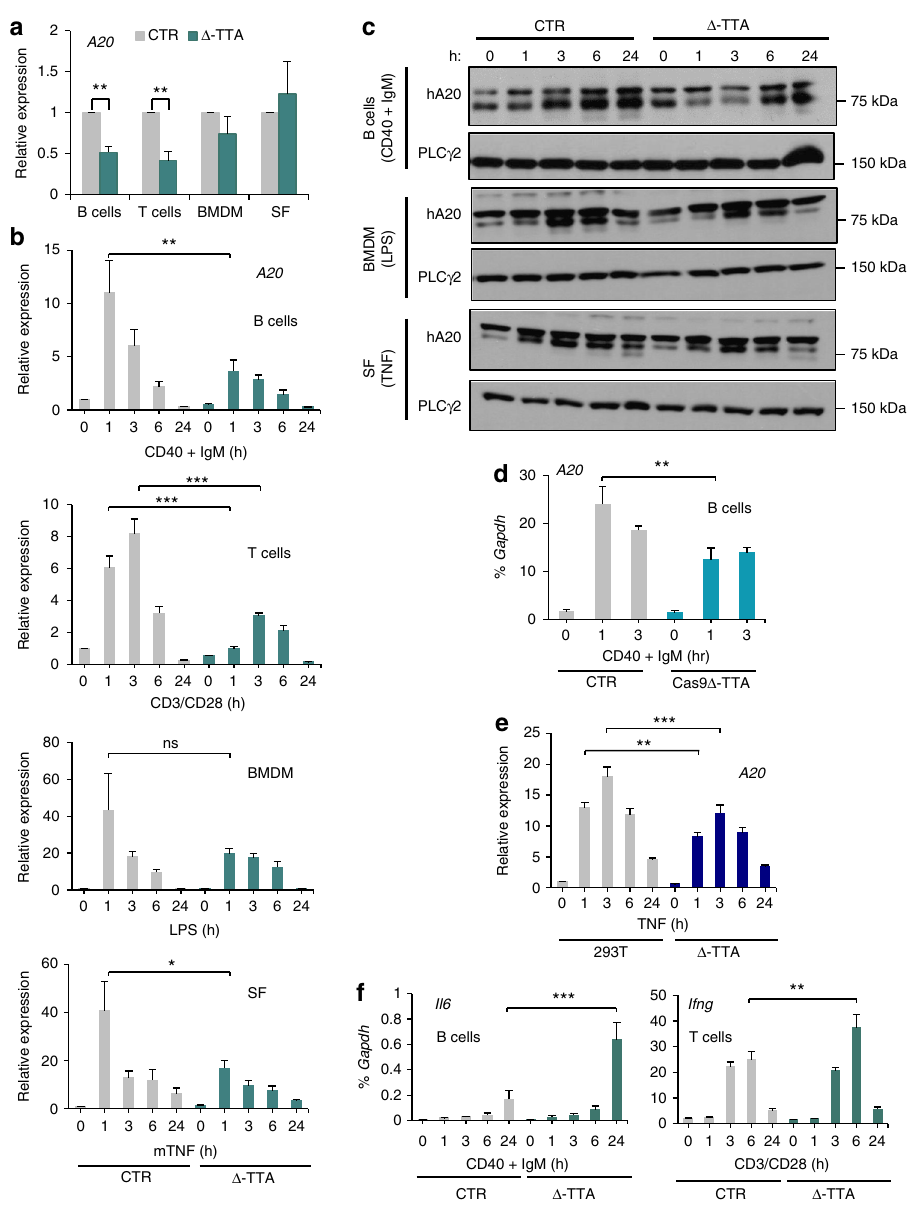
Fig. 5 Genome editing in vivo reveals cell-speci fi c and signal-responsive functions of the TT > A enhancer. a , b qPCR analysis of basal ( a ) or inducible ( b ) hA20 expression in cells from BAC transgenic mice in which TT > A enhancer was deleted using recombineering. Primary B and T cells were isolated from spleens, macrophages cultured from bone marrow (BMDM), and synovial fi broblasts (SFs) were isolated from ankle joints. B cells were stimulated with antibodies against CD40 (2 μ g ml − 1 ) and IgM (5 μ g ml − 1 ), T cells with anti-CD3/anti-CD28-coated beads (1:1 cell to bead ratio), BMDM with LPS (25 ng ml − 1 ), and SF with TNF (20 ng ml − 1 ) for the indicated times. Data are combined from three independent experiments. Error bars indicate mean ± s.e.m., statistical signi fi cance was determined using one-way ANOVA followed by Tukey ’ s multiple comparison test. * P < 0.05; ** P < 0.01; *** P < 0.001; ns, not signi fi cant. c Immunoblot analysis of hA20 protein expression. Representative of two to four experiments. Primary cells were obtained and stimulated as in b . d qPCR analysis of hA20 mRNA in B cells isolated from mice bearing a CRISPR-mediated deletion of TT > A enhancer. Error bars indicate mean ± s.e.m. of four independent experiments, statistical signi fi cance was determined using one-way ANOVA followed by Tukey ’ s multiple comparison test. ** P < 0.01. e CRISPR-mediated deletion of TT > A enhancer affects hA20 expression in 293T cells. Error bars indicate mean ± s.e.m. of fi ve independent experiments, statistical signi fi cance was determined using one-way ANOVA followed by Tukey ’ s multiple comparison test. ** P < 0.01; *** P < 0.001. f qPCR analysis of cytokine mRNA from ex vivo-stimulated B and T cells. Error bars indicate mean ± s.e.m. of three independent experiments, statistical signi fi cance was determined using one-way ANOVA followed by Tukey ’ s multiple comparison test. ** P < 0.01; *** P <